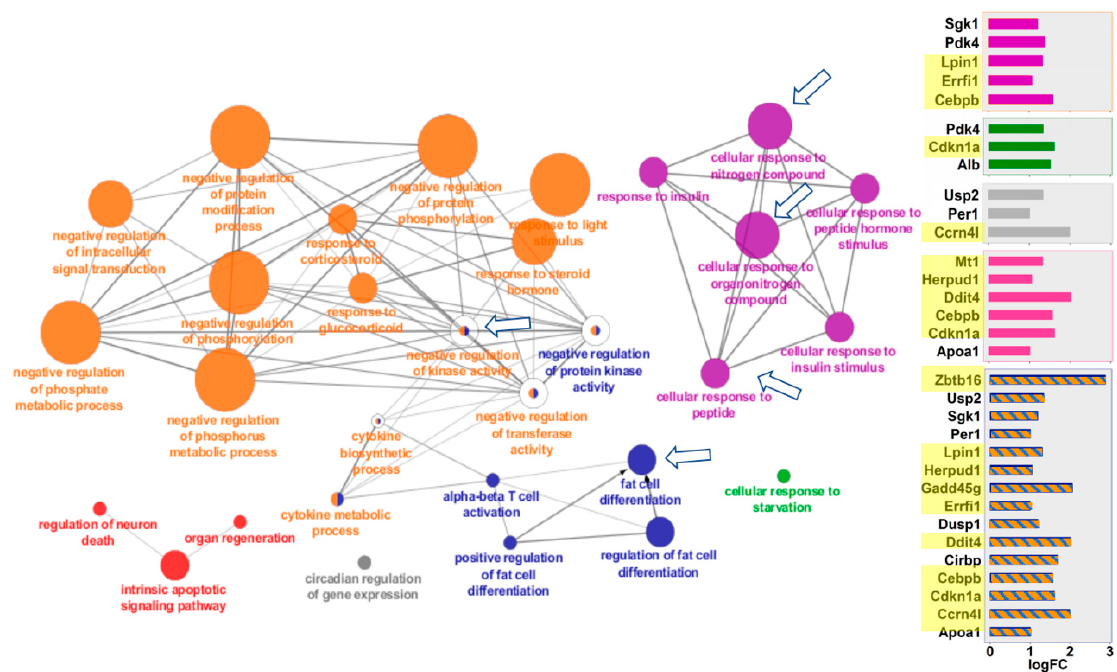
Figure 4. Mouse kidney pathways overexpressed in space. Functional gene networks that were upregulated in kidney in response to spaceflight. ClueGO Cytoscape visualizes the interactions of gene clusters in a functionally grouped network using enrichment maps. Nodes in the same cluster are assigned the same node color and node size indicates the number of mapped genes in each GO term. The node label is determined on the basis of common themes in the processes within the cluster. Bar graphs of the fold-change (FC) of individuals genes are shown on the right. Gene names highlighted in yellow were also overexpressed in mouse liver after spaceflight. Data in the bottom panel with orange and blue stripes applies to both the orange and blue clusters. Arrows mark the gene clusters that were also seen in Space-flown liver. Additional information on the clusters can be found in Supplemental Figure S2.